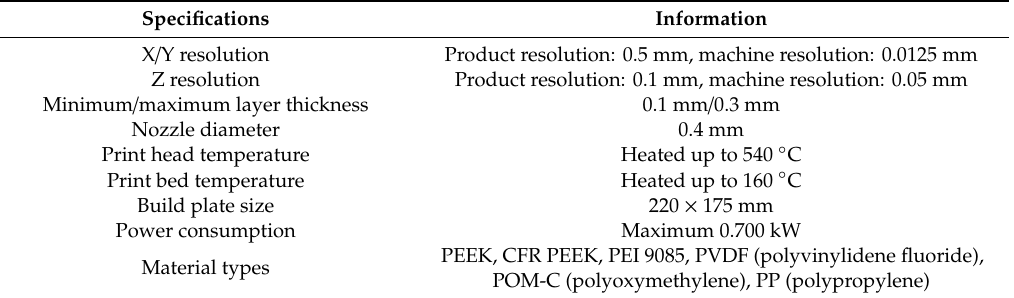
Table 2. Technical specifications of Apium P220 [44].